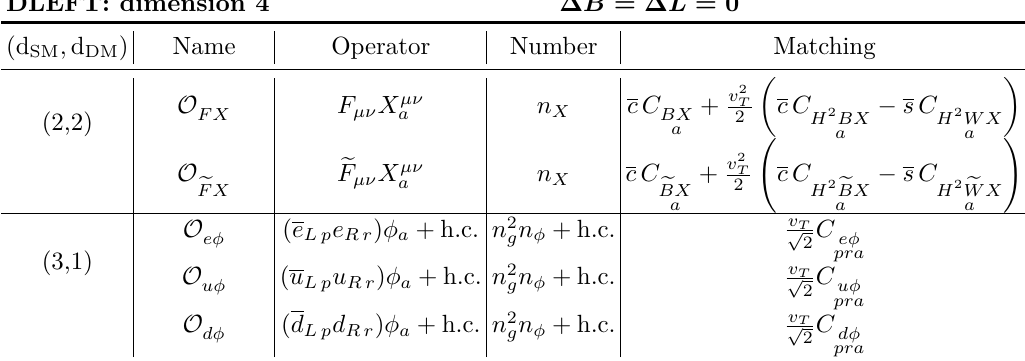
is not the same as eφ